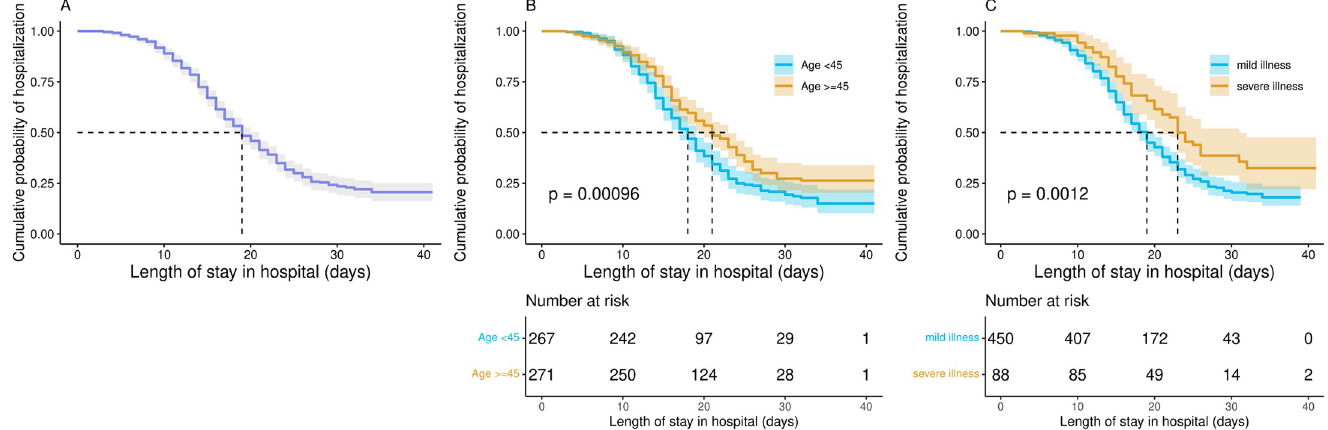
Fig 2. Cumulative probability of hospitalization Kaplan–Meier survival curves with at-risk tables for COVID-19 confirmed patients. Shading shows 95% CIs. 538 COVID-19 confirmed patients of all ages (A), 267 patients younger than 45 years and 271 patients at least 45 years (B), 450 mild cases and 88 severe cases (C).